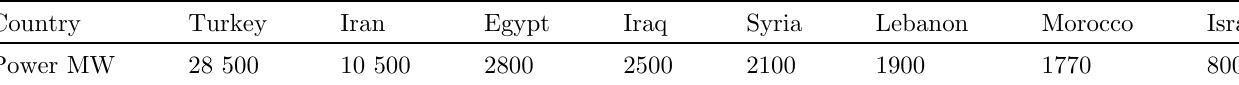
Table 2. Hydropower in the Middle East and North Africa.